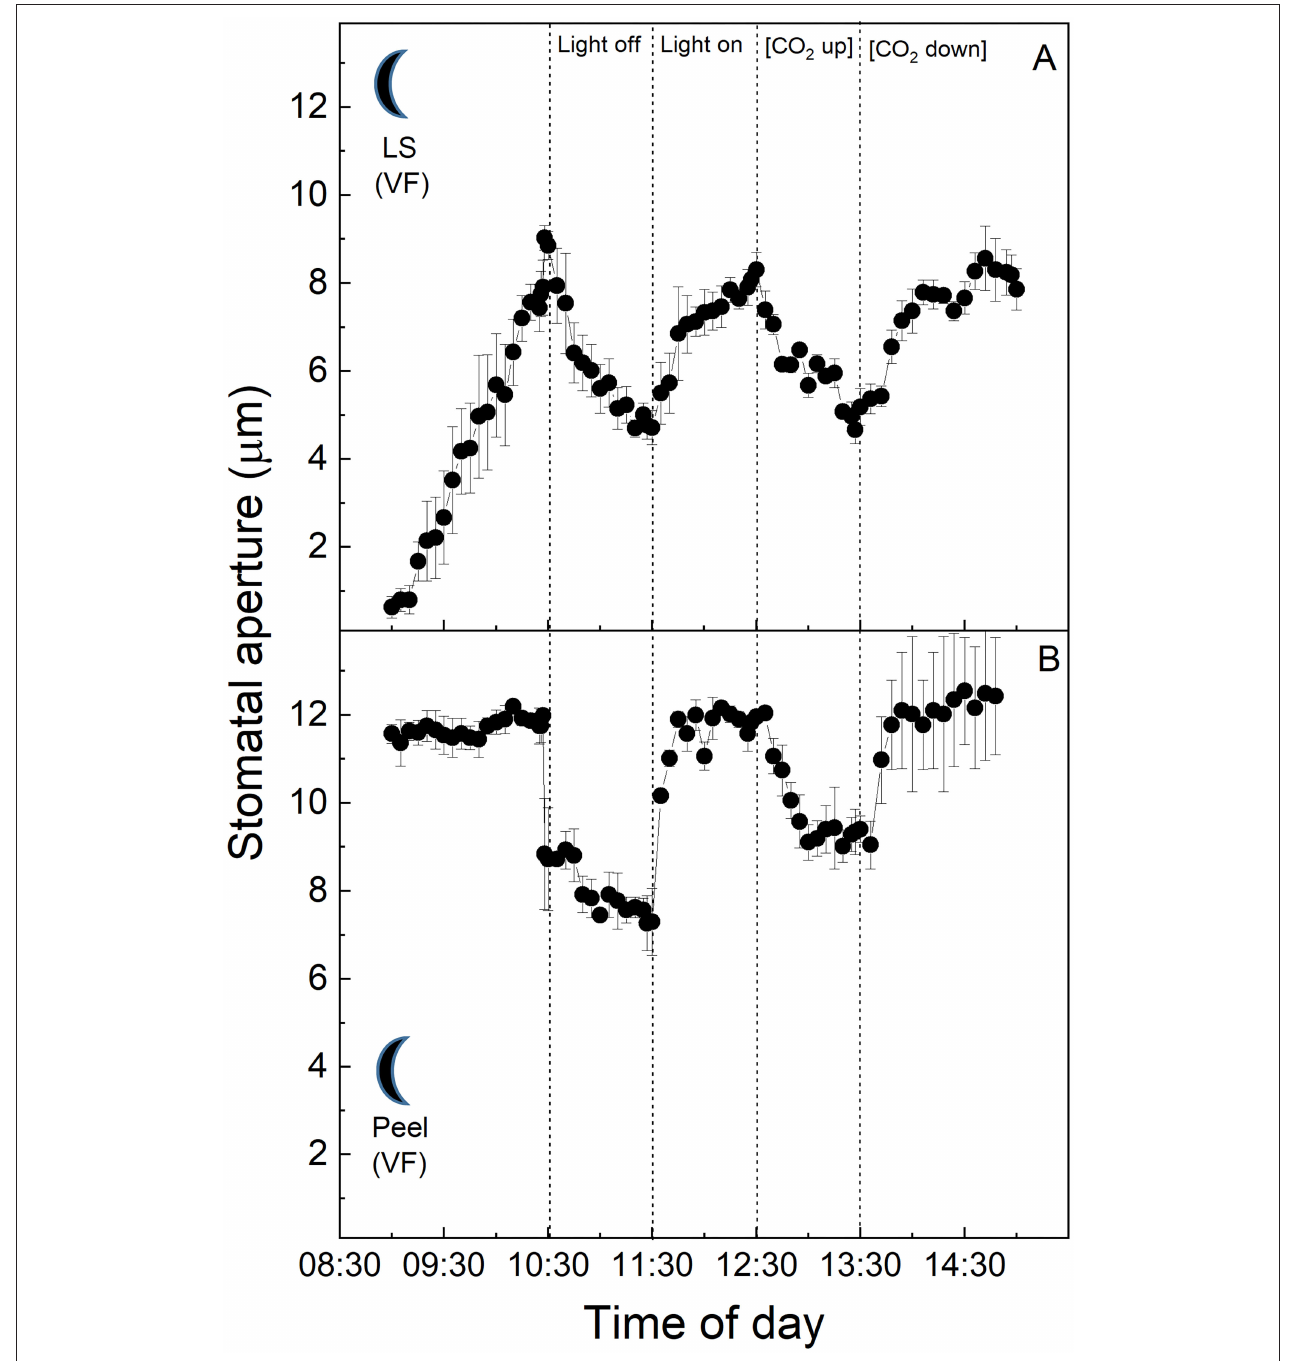
FIGURE 4 | (A) Vicia faba leaf fragment from the “dark” cabinet.; (B) Abaxial isolated epidermis of Vicia faba leaf from the “dark” growth chamber (reverse light period 8:00 p.m. to 8:00a.m.). Light intensity was changed from photon flux density of 400 ± 10 µ mol m − 2 s − 1 to darkness, as indicated, and [CO 2 ] was changed from 120 to 650 µ mol mol − 1 , as indicated. The temperature of the chamber was maintained at 23 ± 1 ◦ C. The values are means of four repetitions ( ± SE). The moon symbol represents plants taken from the dark-grown chamber.